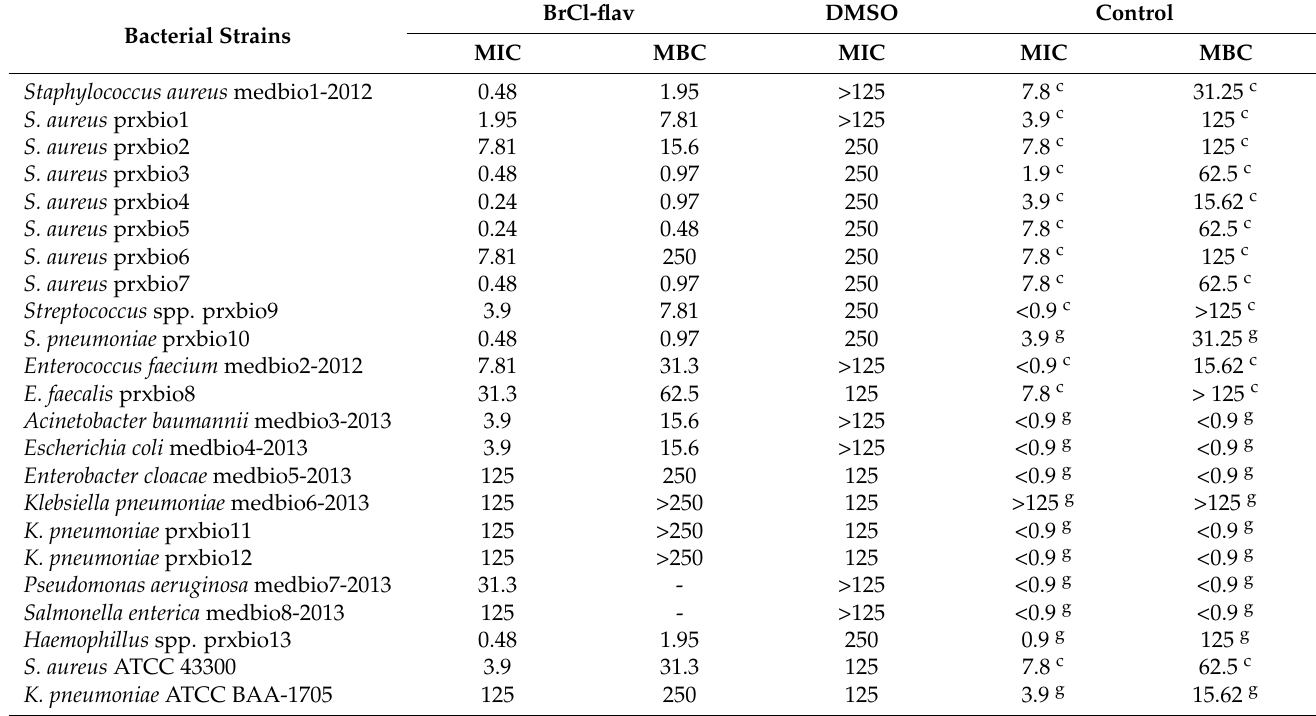
Table 1. Minimum inhibitory concentration and minimum bactericidal concentration of BrCl-flav against tested clinical isolates ( µ